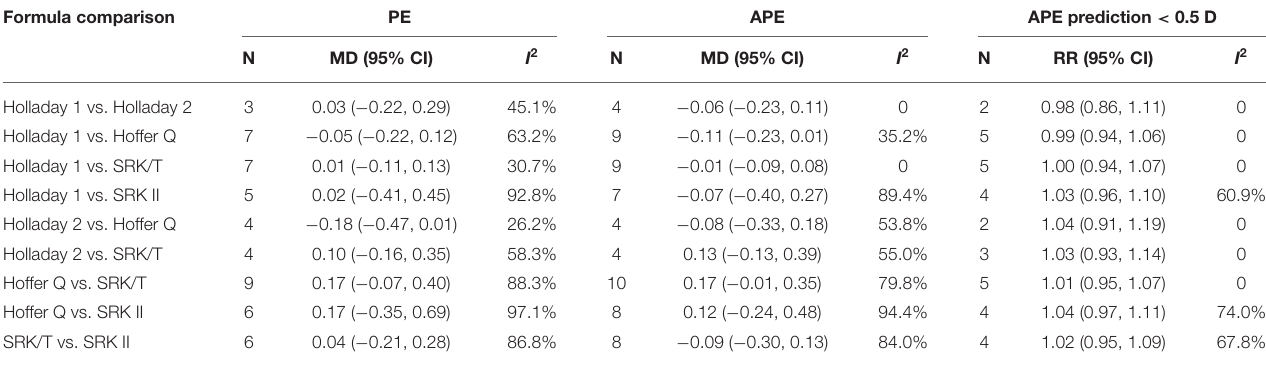
TABLE 2 | Mean difference of prediction error (PE), absolute prediction error (APE), and relative risk of APE prediction < 0.5 D. Formula